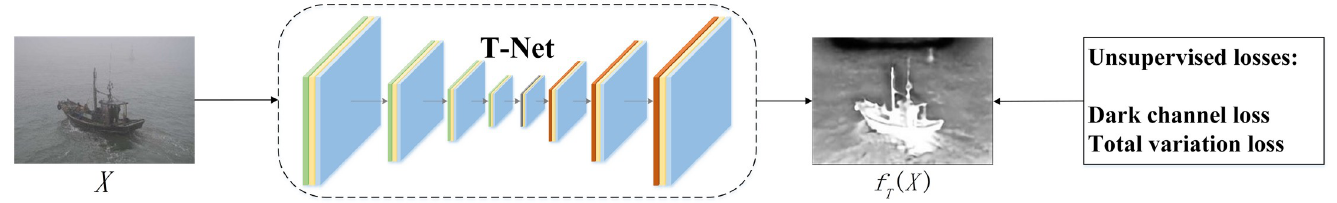
PLOS ONE | https://doi.org/10.1371/journal.pone.0253214 June 28,